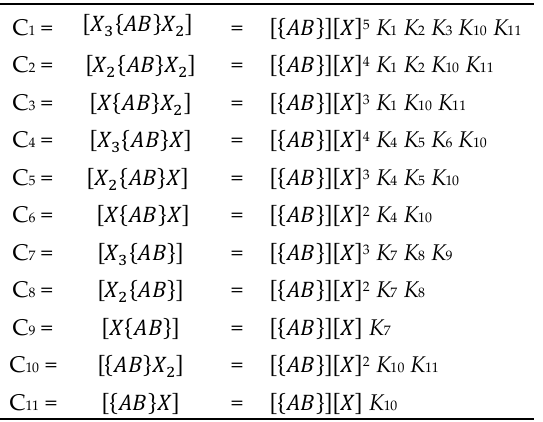
Table A1. Concentrations C i , calculated using Equation